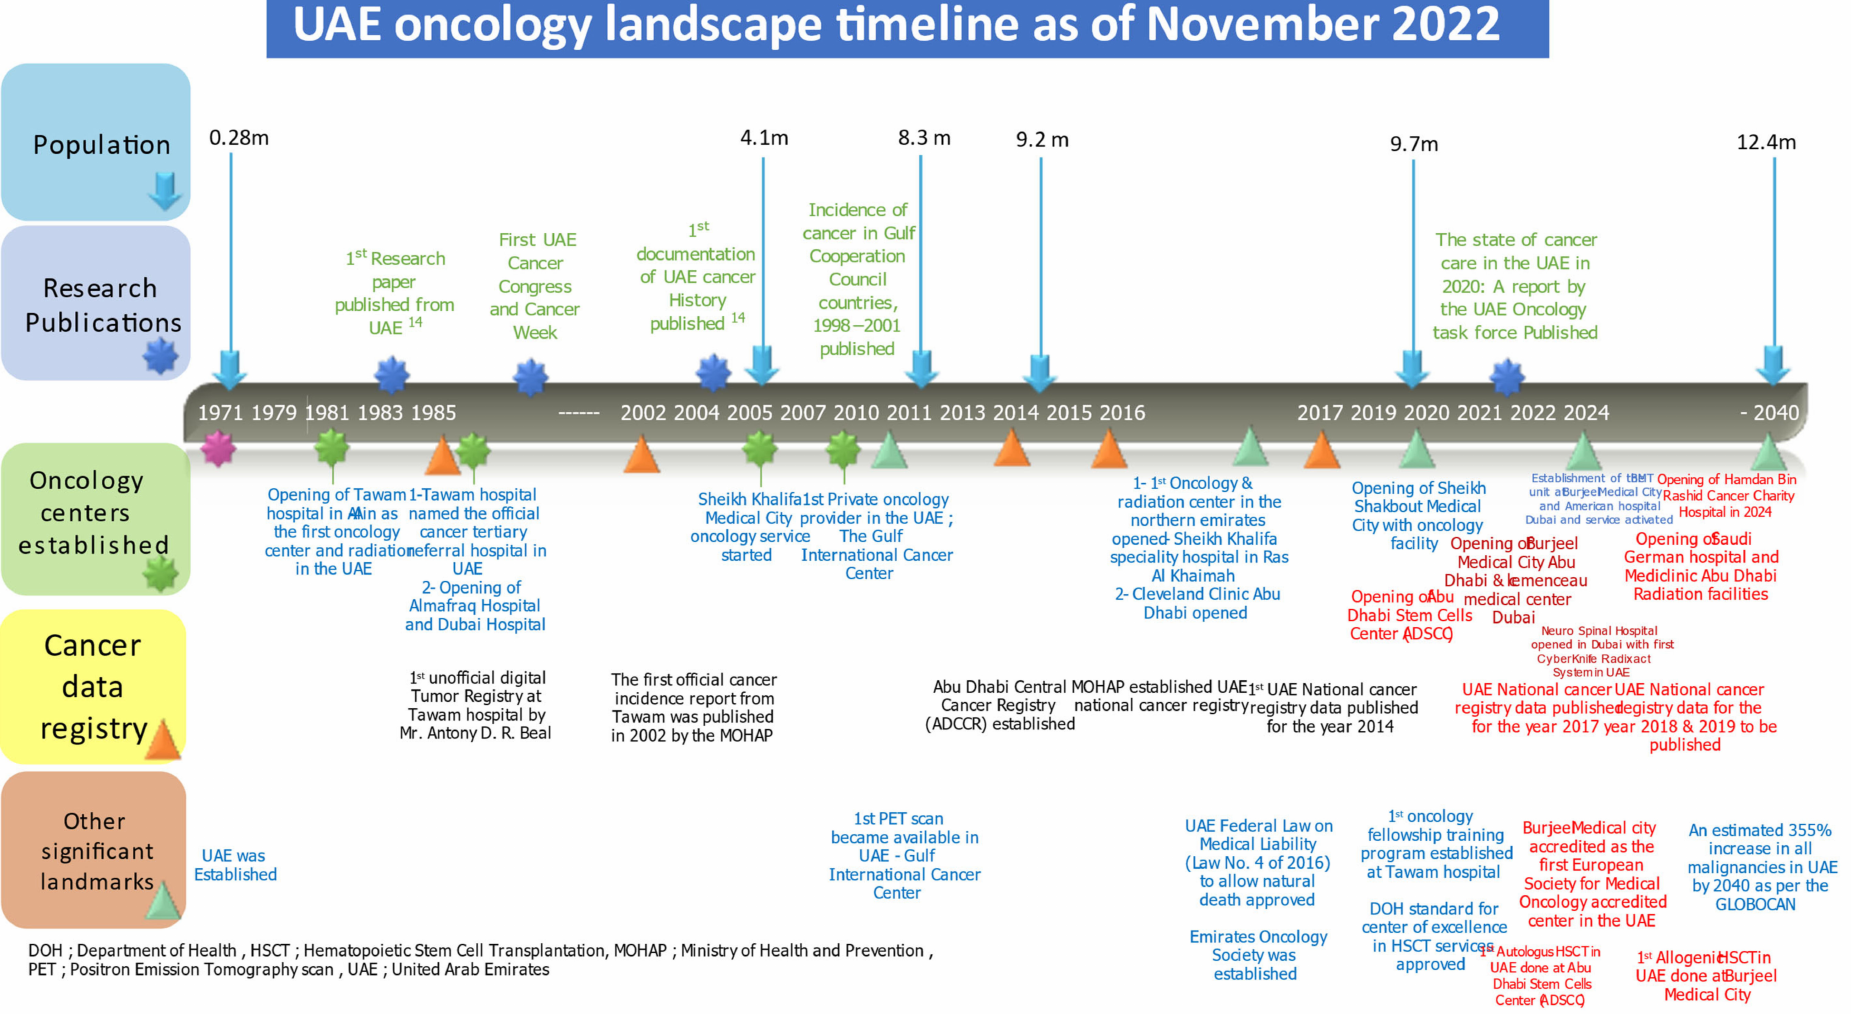
Figure 1. UAE oncology landscape timeline as of November